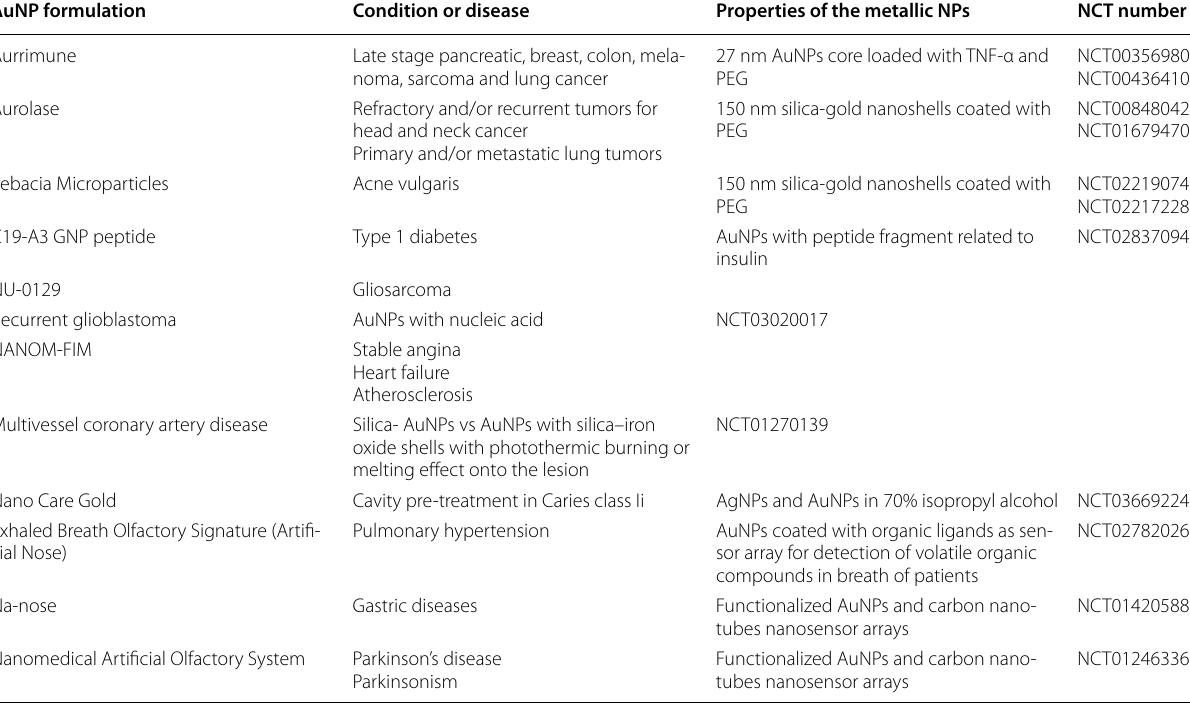
Table 2 AuNP-based formulations approved for clinical trials by FDA. Adapted from [19, 32] AuNP formulation Condition or